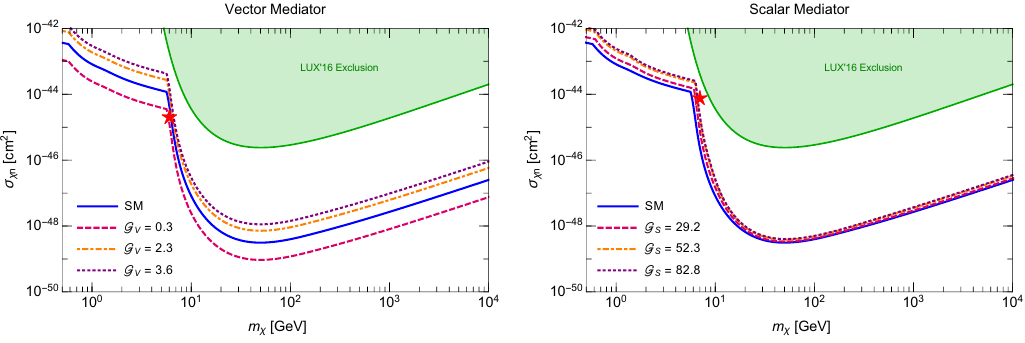
Figure 1 . One neutrino event contour lines for the two types of mediators, considering a Xe target detector. We show on the left (right) panel three examples for the vector (scalar) mediator. We also show the SM one neutrino event contour line (in blue) for comparison. The red star is a point for which we will show the energy spectrum. The green region is excluded by LUX at 90% of C.L.